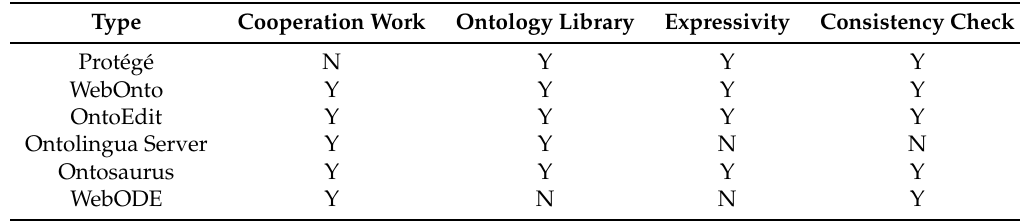
Table 2. Comparison of Different Ontology Editors.